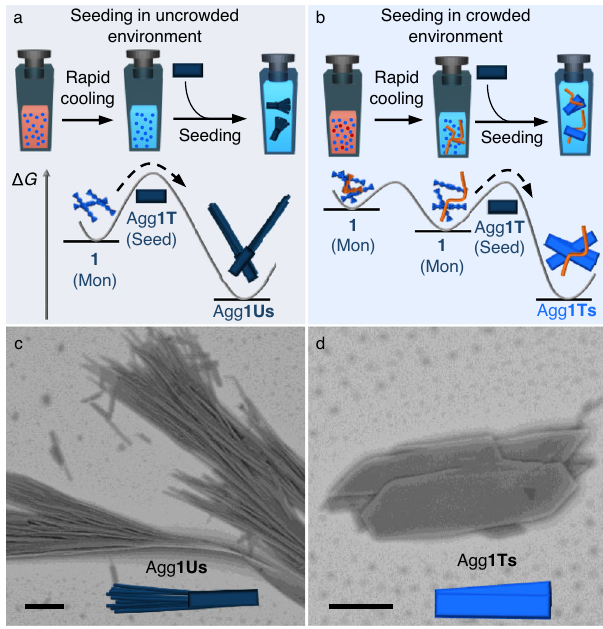
Fig. 4 | Seeded supramolecular polymerisation in uncrowded and crowded environments. a , b schematic depiction of the sample preparation protocol and energy landscape associated with seeded polymerisation in uncrowded ( a ) and crowded( b )environments.SEMmicrographsofthesupramolecularmorphologies obtainedfromtheexperimentalprotocolillustratedin a ( c )and b ( d ),respectively. The scale bars correspond to 5 µ